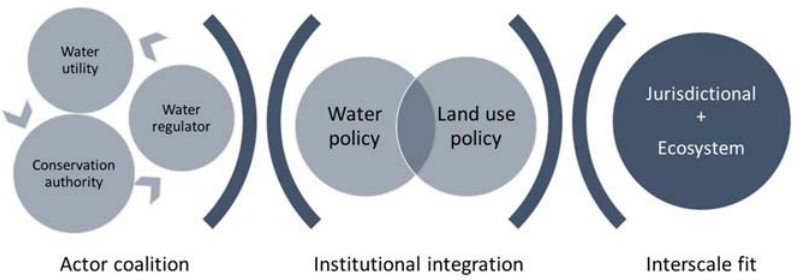
Figure 7. The inclusion of a new actor in an actor coalition provides discussions about institutional integration for increased ecosystem fit of adaptive actions.